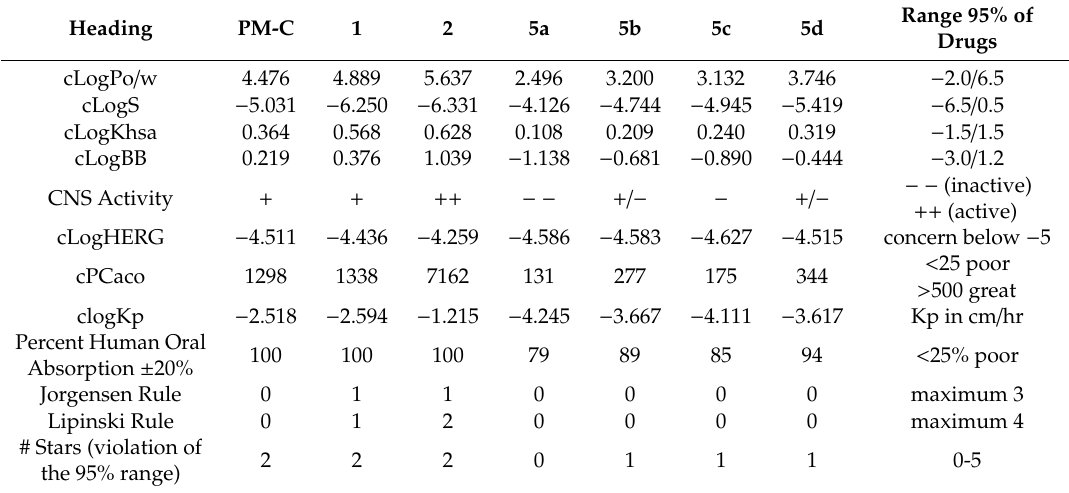
Table 2. Calculated ADMET (Absorption, Distribution, Metabolism, Elimination and Toxicity) properties of PM- C , 1 , 2 , and 5a-d